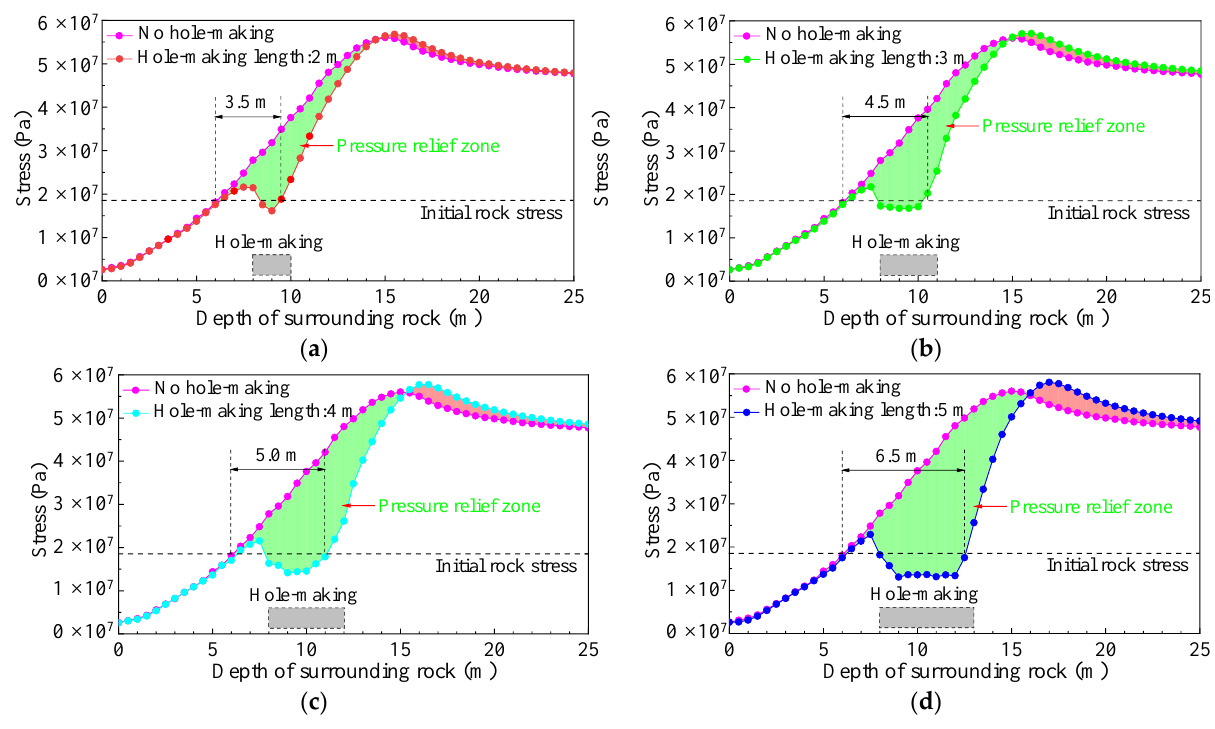
Figure 18. Comparison of stress curves of roadway rib at different hole-making lengths in the mining influence stage. ( a ) Hole-making length = 2 m; ( b ) Hole-making length = 3 m; ( c ) Hole-making length = 4 m; ( d ) Hole-making length = 5 m.